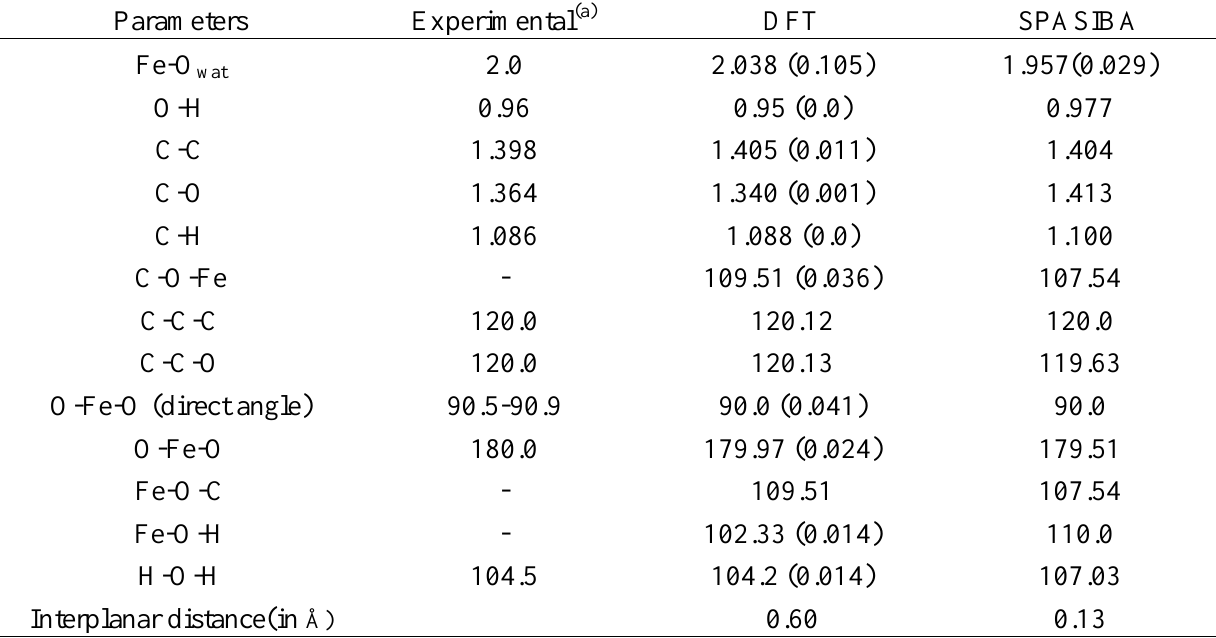
Table 2b . DFT (sextet electronic state) and SPASIBA optimized structural parameters for the